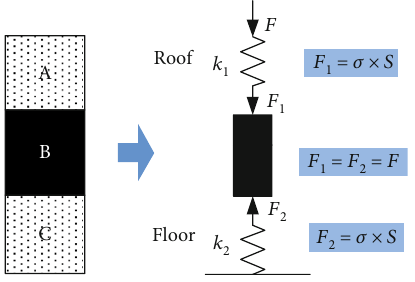
Figure 2: Mechanical analysis of coal-rock combined body model with same diameter.